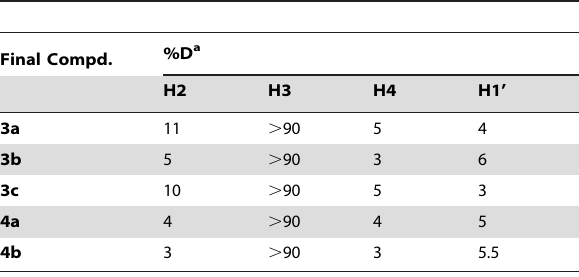
Table 2. Incorporation of deuterium in the reduction with NaBD 3 CN.